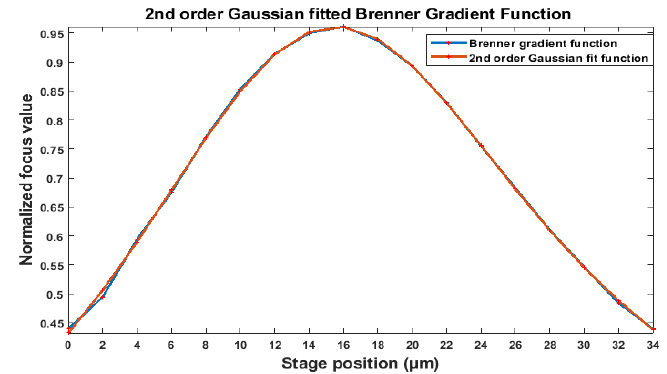
Figure 6. Representation of the focus curve obtained from the Brenner gradient method.